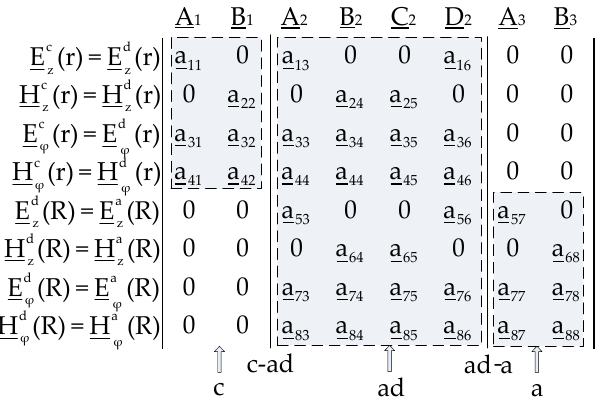
Figure 2. The complex dispersion equation of the tube waveguide with a central channel.